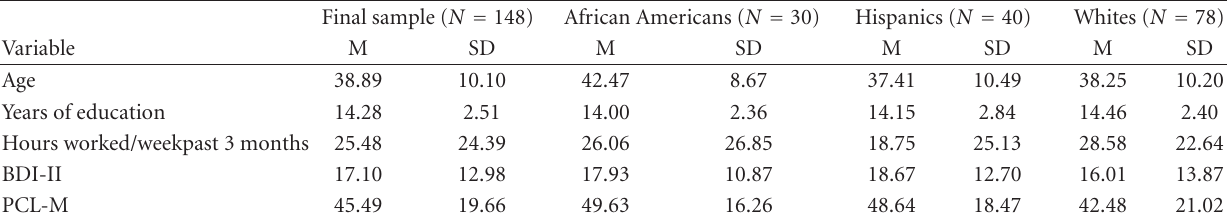
Table 1: Final sample